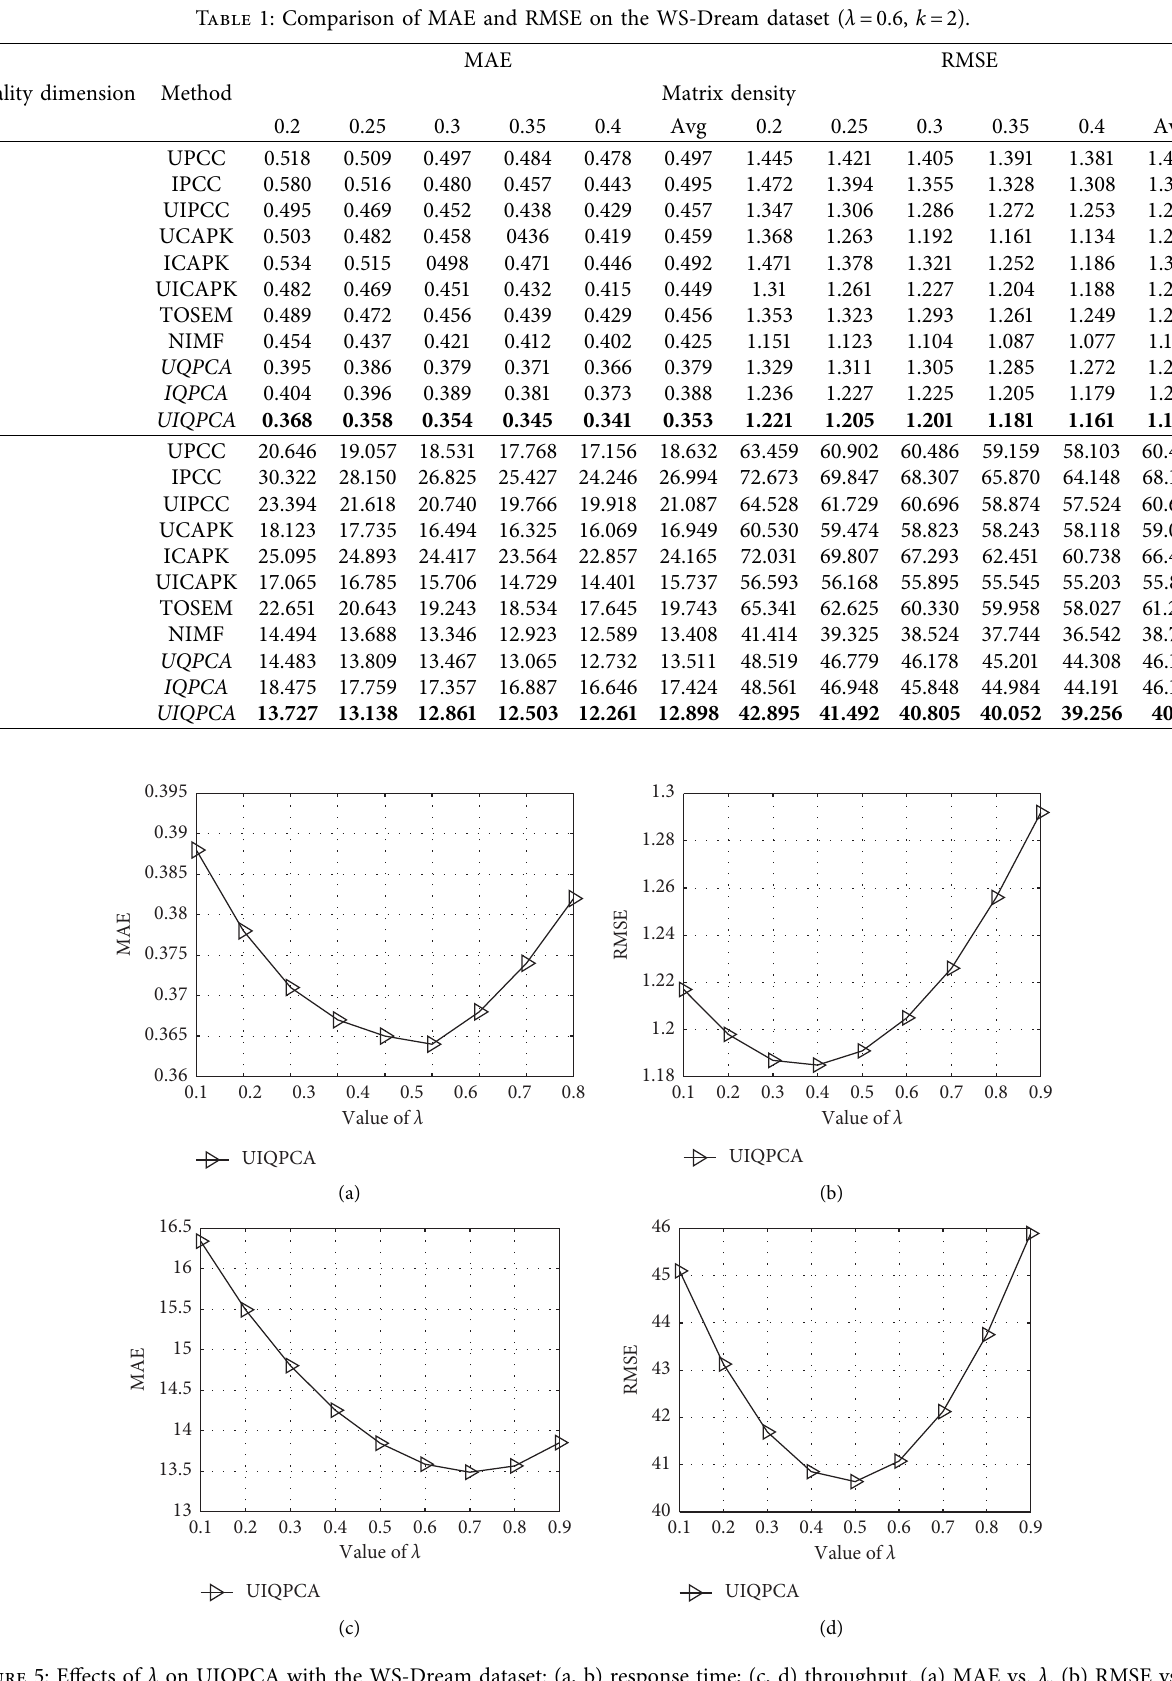
Figure 5: Effects of λ on UIQPCA with the WS-Dream dataset: (a, b) response time; (c, d) throughput. (a) MAE vs. λ . (b) RMSE vs. λ . (c) MAE vs. λ . (d) RMSE vs. λ